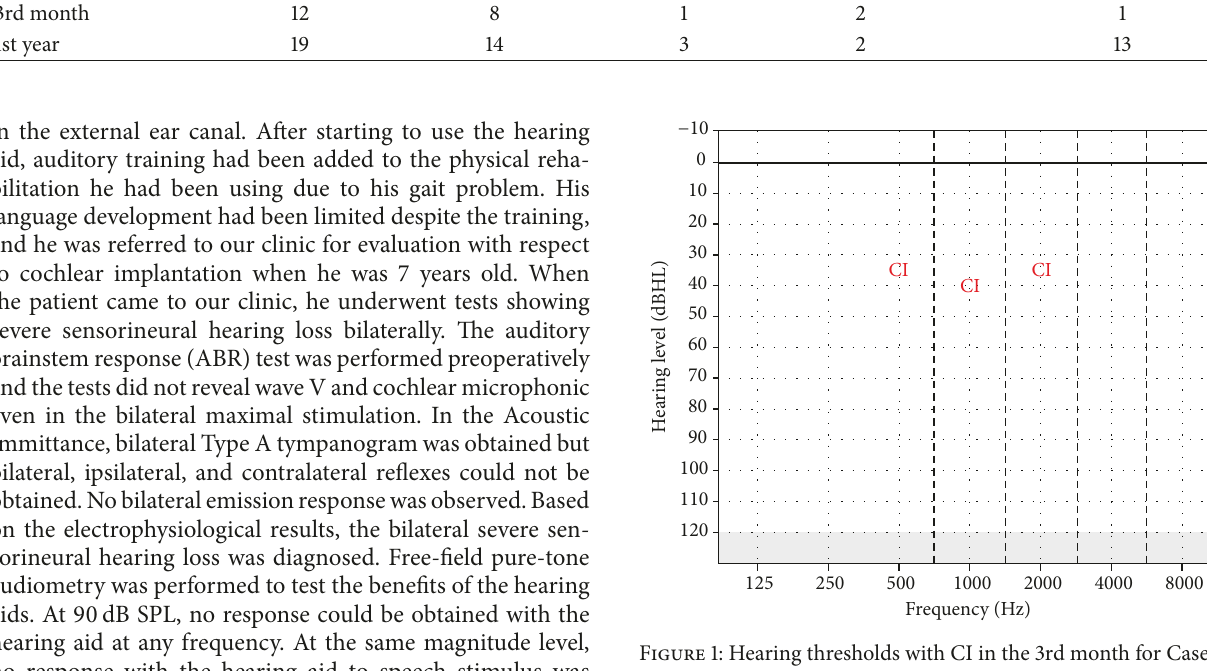
Figure 1: Hearing thresholds with CI in the 3rd month for Case 1